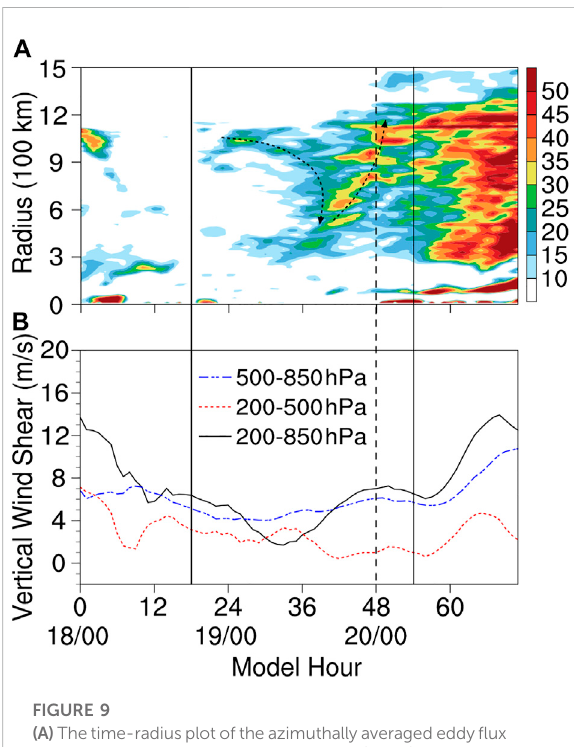
FIGURE 9 (A) Thetime-radiusplotoftheazimuthallyaveragededdy fl ux convergence of angular momentum (m s − 1 day − 1 ) at 200 hPa, and (B) time series of the vertical wind shear (m s − 1 ) in the 10 ° × 10 ° typhoon-centered region from 200 hPa to 850 hPa (black), 200 hPa to 500 hPa (red) and 500 hPa to 850 hPa (blue). The reference lines represent the same meaning as those in Figure